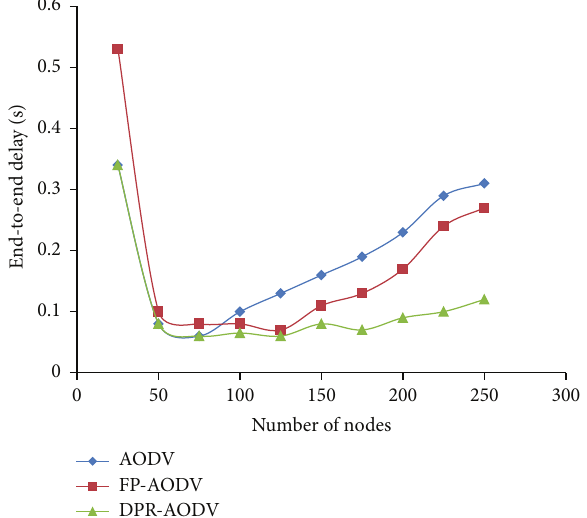
Figure 5: Normalized throughput versus number of mobile nodes.